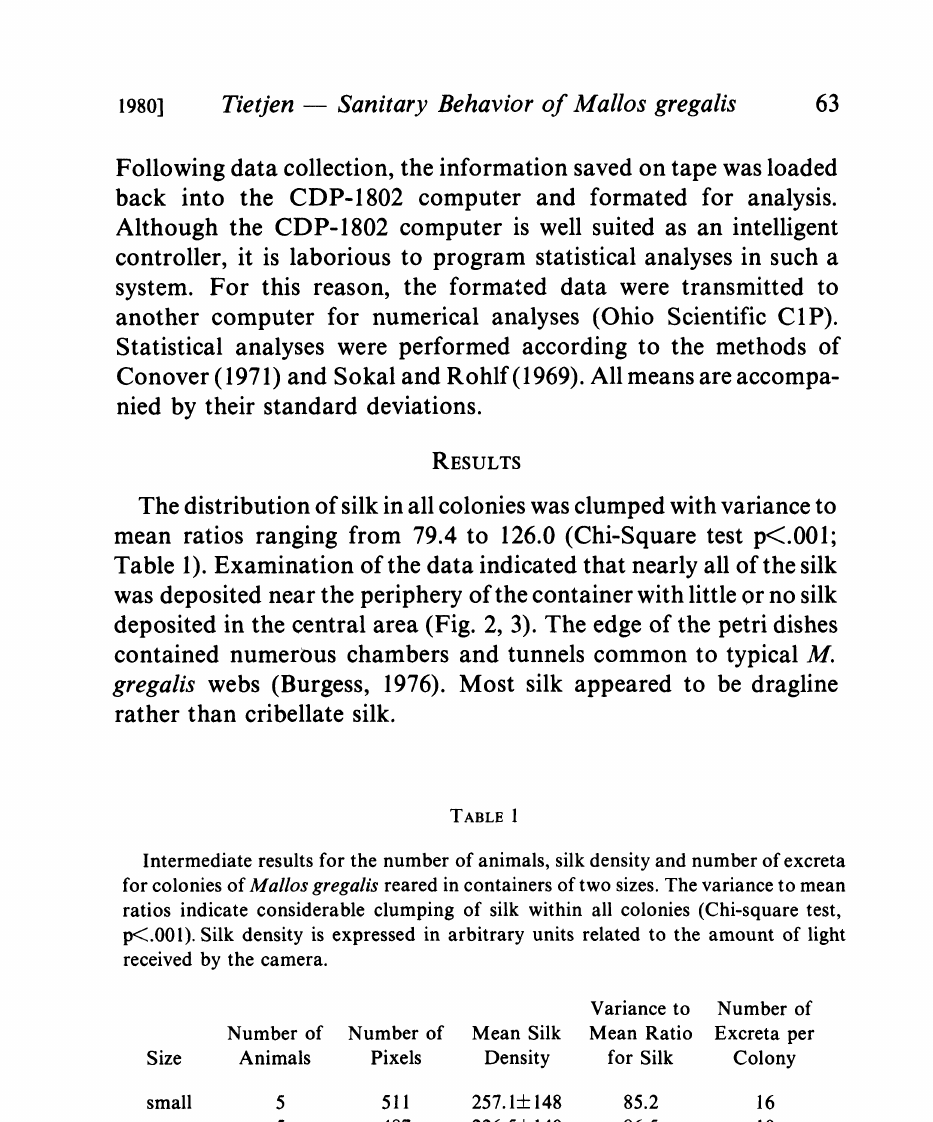
Intermediate results for the number of animals, silk density and number of excreta for colonies of Mallos gregalis reared in containers of two sizes. The variance to mean ratios indicate considerable clumping of silk within all colonies (Chi-square test, p<.001). Silk density is expressed in arbitrary units related to the amount of light received by the